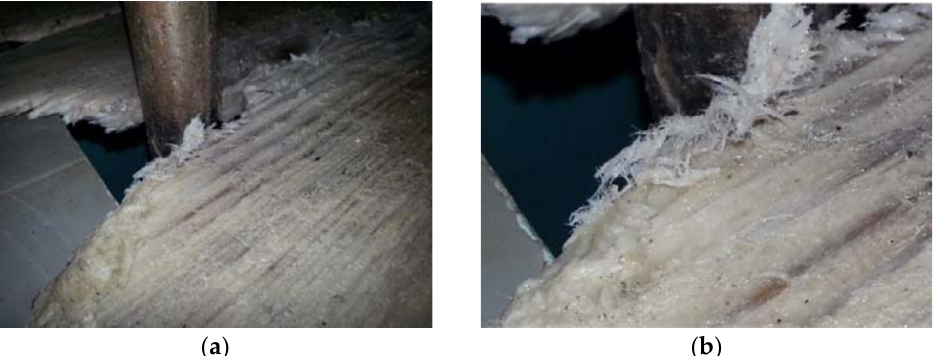
Figure 1. Degradation of the wooden cover of the drinking water treatment facility’s internal reservoir ( a ), and respective detail ( b ) and respective detail ( b